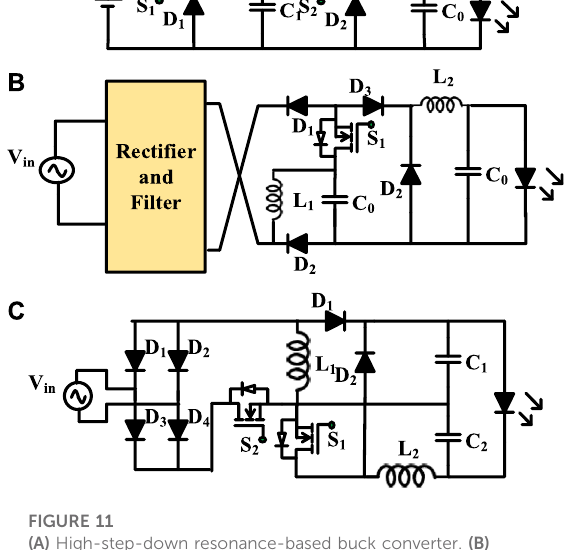
FIGURE 11 (A) High-step-down resonance-based buck converter. (B) Integrated buck-boost and buck converter. (C) Integrated parallel buck-boost and boost